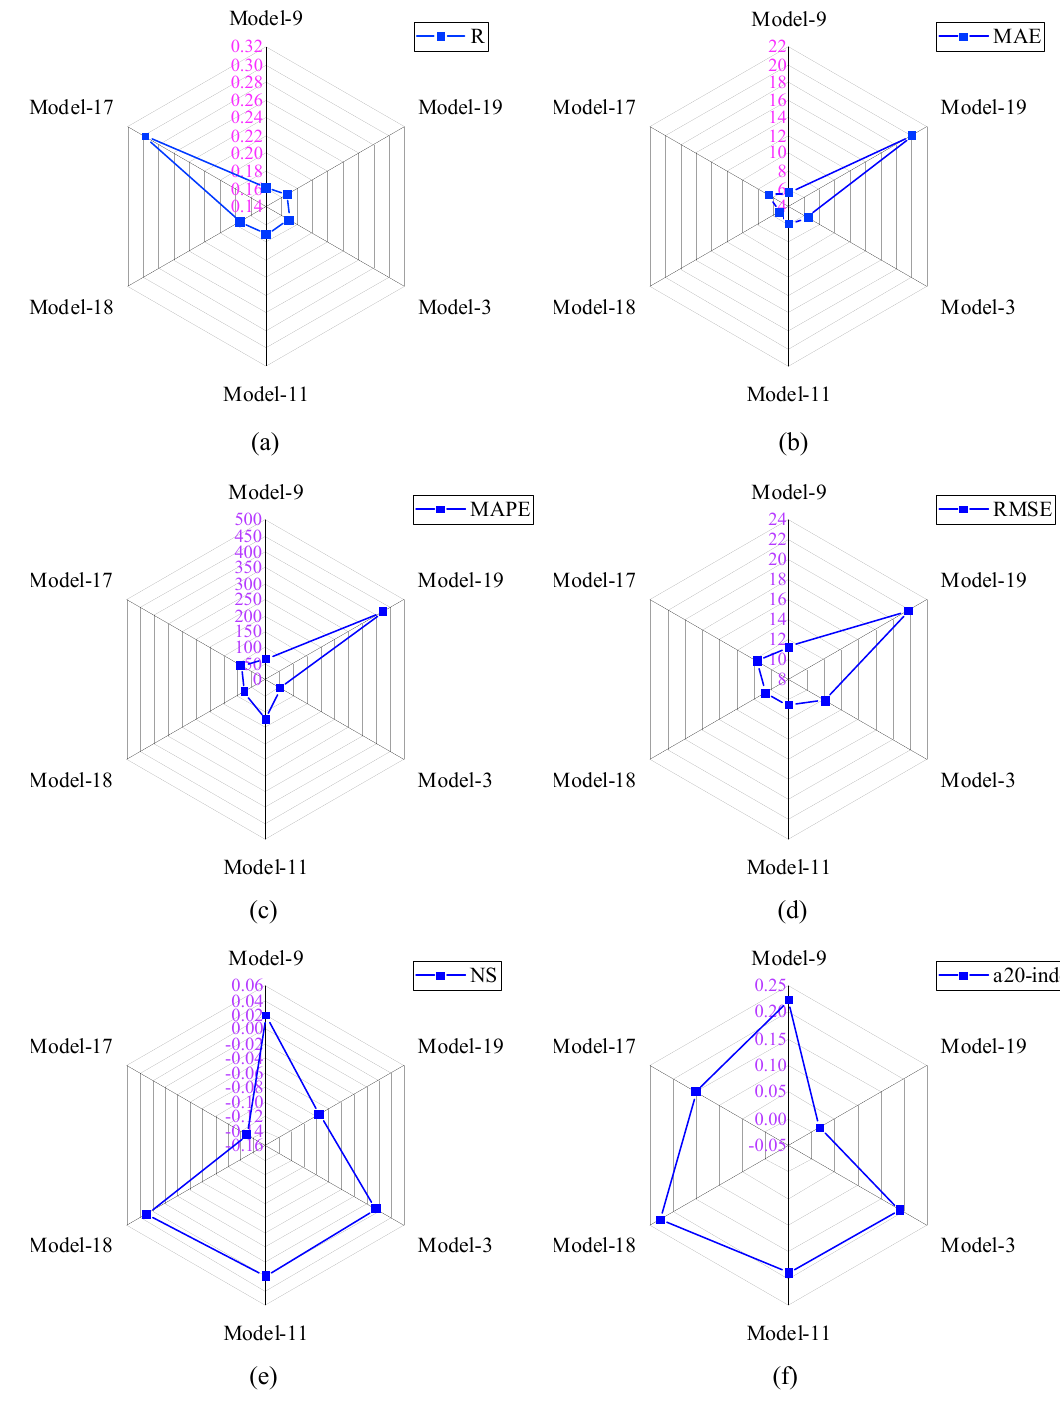
Figure 8. Comparison of performance indices of Group-II models; ( a ) R, ( b ) MAE, ( c ) MAPE,